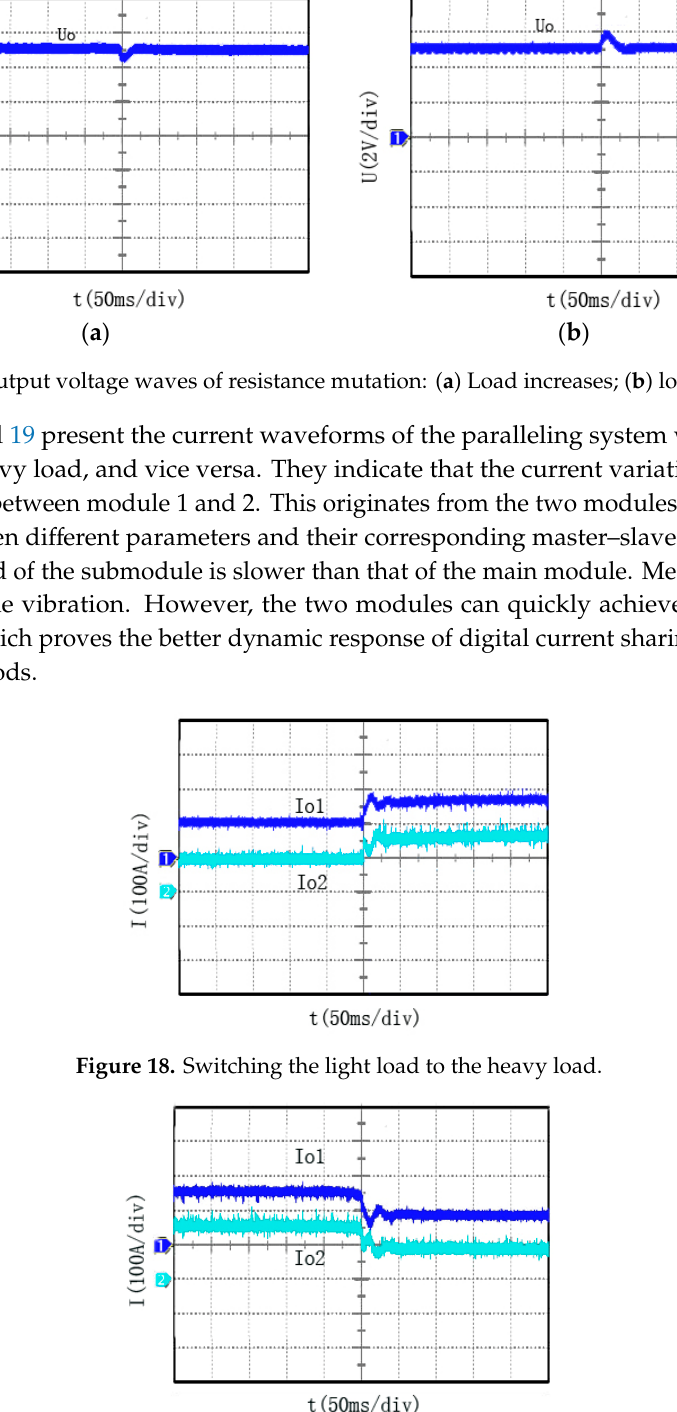
( b ) Figure 15. The experiment voltage waves of the DC power generation: ( a ) Output voltage wave; ( b ) output voltage spectrum. Figure 16 shows the experiment waves of the output current and the corresponding spectrum when a single rectifier module is in operation. The vertical axis is logarithmically and uniformly distributed. Moreover, the unit ratio is 100 A. When the main wave of the output current is stable, the main frequency is still 0 Hz, which conforms to DC characteristics. Although there is a certain amplitude in other frequency bands, none of them exceeds 3 A. ( a ) ( b ) Figure 16. The experiment current waves of the DC power generation: ( a ) Output current wave; ( b ) output current spectrum.